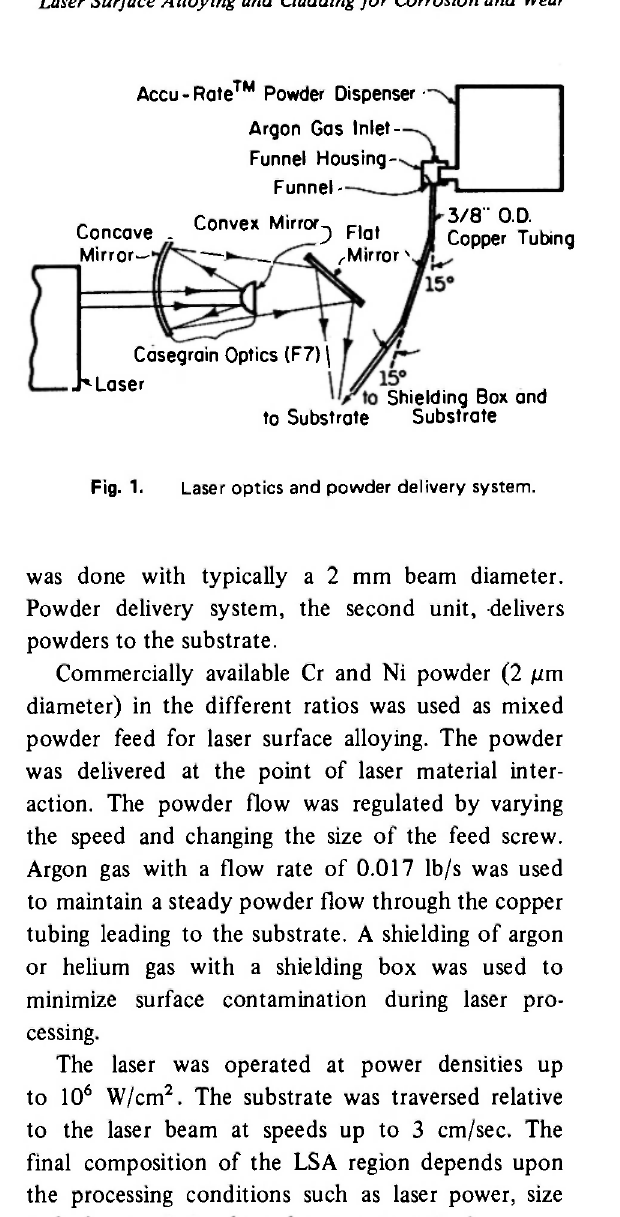
Fig. 1. Laser optics and powder delivery system.